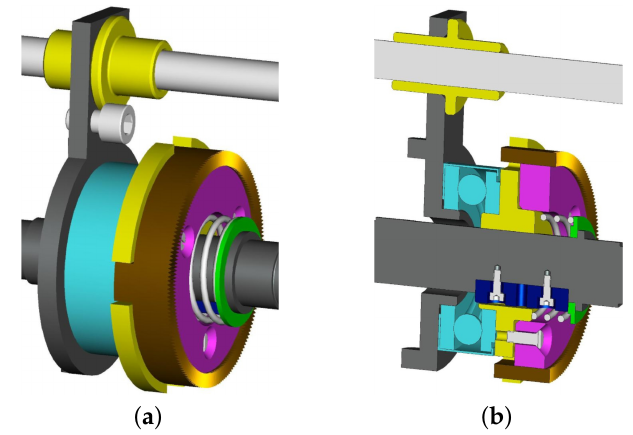
Figure 2. The structure of Group C under switched off status. ( a ) Group C in the switched off status. ( b ) Cross-sectional view of Group C which in switched off status.